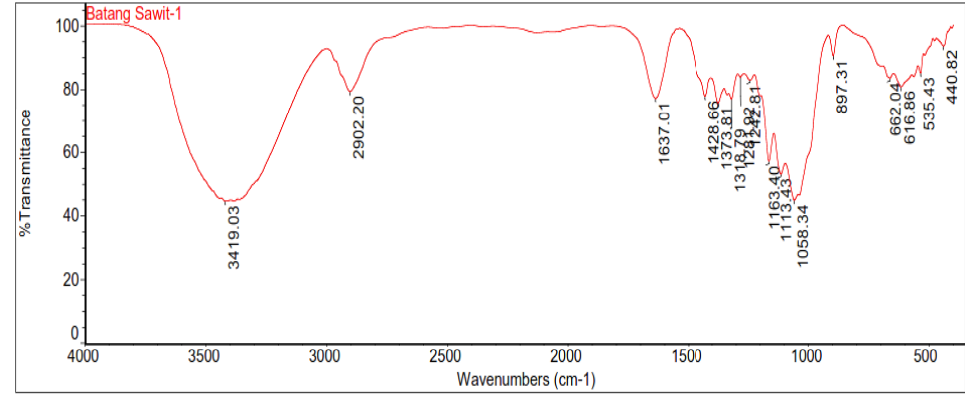
Figure 3. FTIR spectra of cellulose from OPT